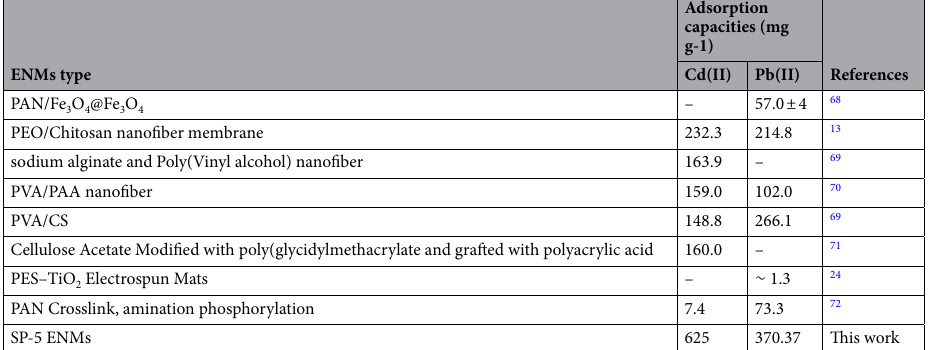
Table 6. Comparison of SP-5 ENMs with other ENMs.